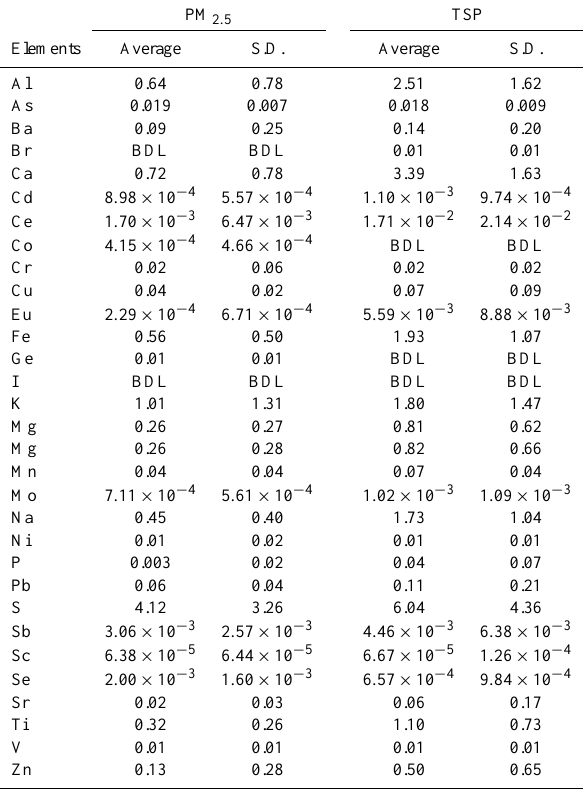
Table 2. Principle component analysis of the major elements. Rotated component